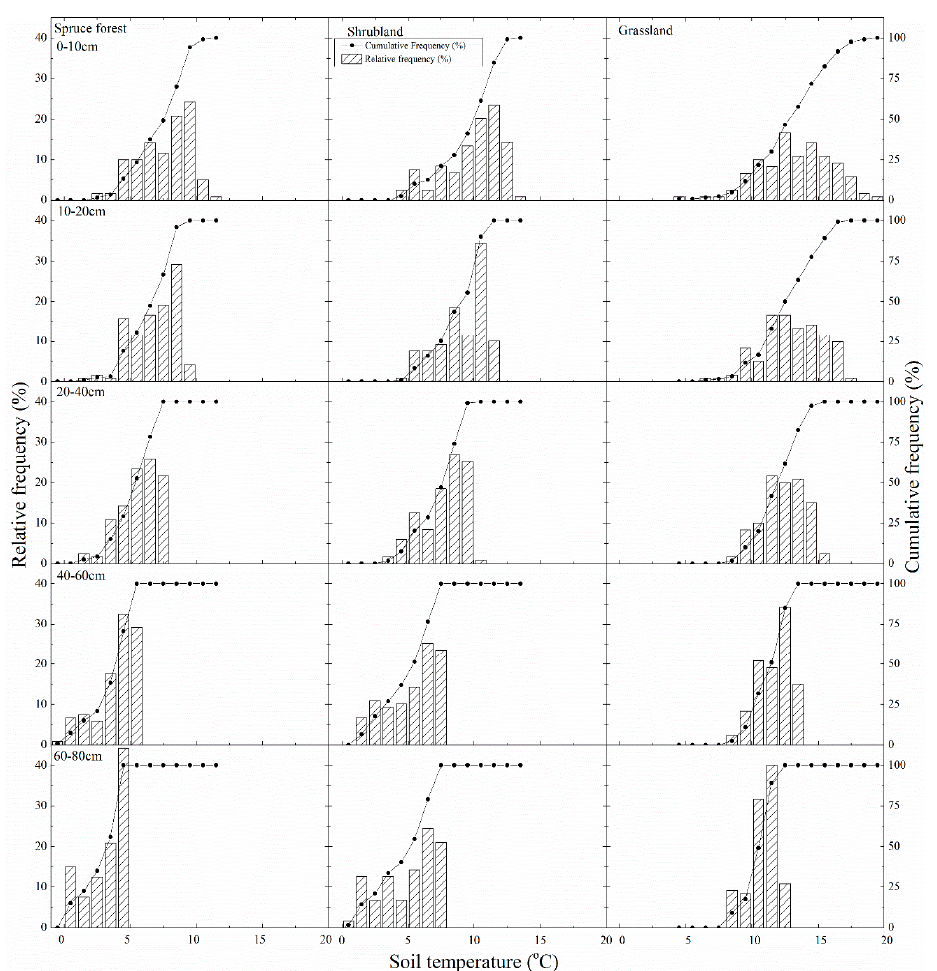
Figure 6. Frequency and cumulative frequency distribution of soil temperature at different soil depths in the three typical types of vegetation during the growing season.